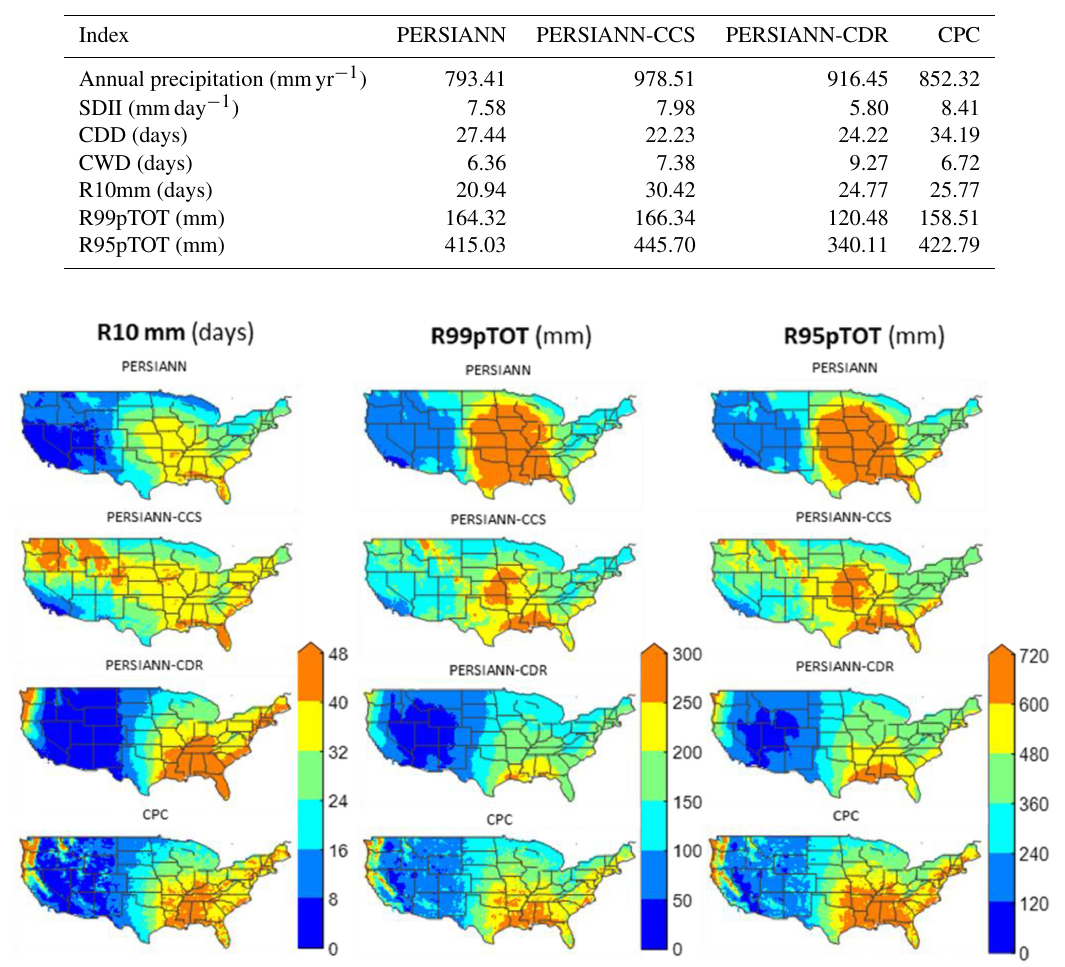
Figure 5. Extreme precipitation indices (R10mm, R99pTOT and R95pTOT) for PERSIANN, PERSIANN-CCS, and PERSIANN-CDR over the CONUS (see Table 4 for definitions of the